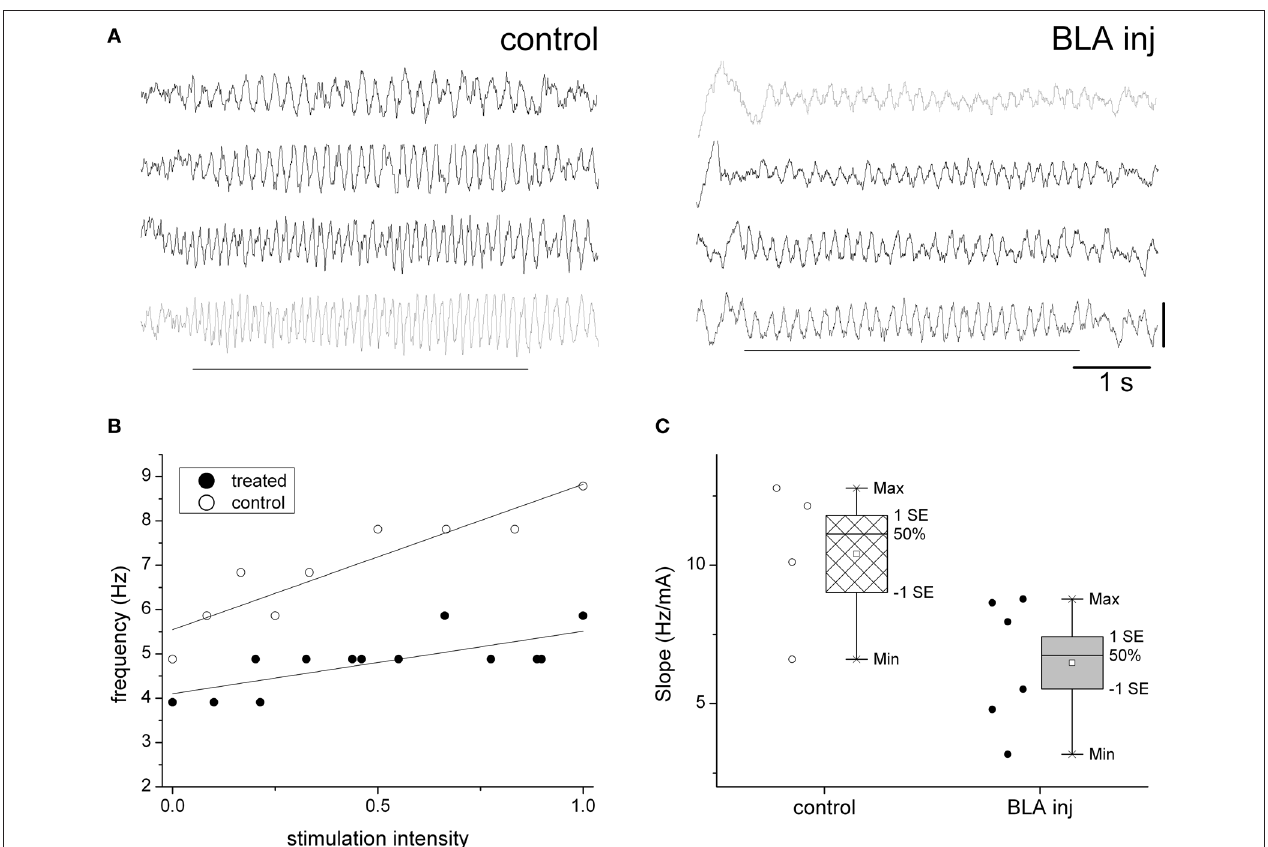
FiguRE 3 | Delayed attenuation of the hippocampal theta response to brainstem activation, 96 h after picrotoxin injection in the BLA. (A) Sample traces of hippocampal EEG of urethane anesthetized rats during RPO stimulation (see markers) at increasing intensities, 4 days after picrotoxin injection in the BLA (right) or in the adjacent area (anatomical control, left). Note strong modulation of theta frequency in the control rat (frequency increase from 4.5 to 8.5 Hz) and